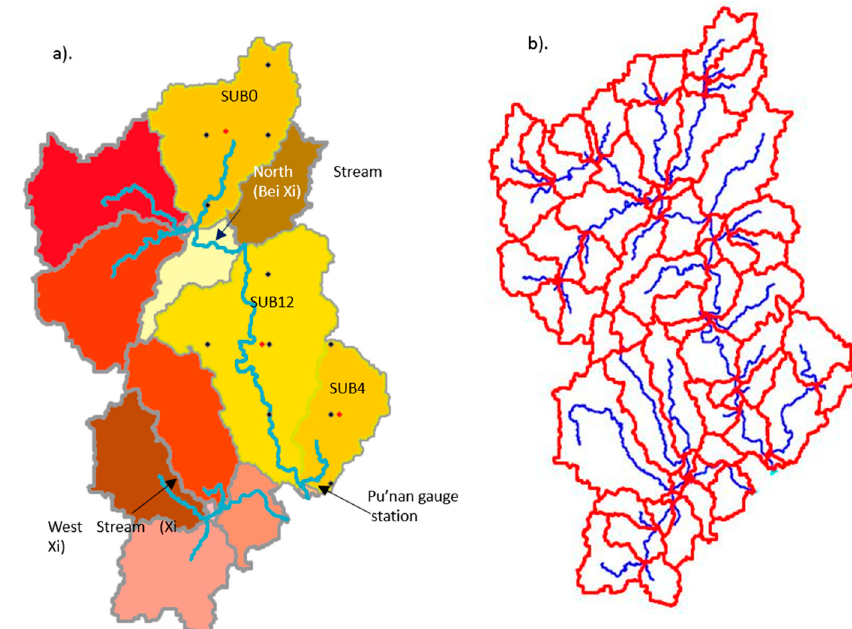
Figure 3. Two versions of watershed delineation. ( a ) Coarser delineation for data interpolation; ( b ) finer delineation for Hydrological Simulation Program-Fortran (HSPF) modeling. The three yellow subcatchments (SUB0, SUB12, and SUB4) contain the locations that are identified as crucial for runoff generation, and the WRF model output at these points (little black dots) within these sub-basins was subsequently interpolated utilizing the Thiessen Polygon method onto the centroids (red dots) of these sub-basins as HSPF input. See Section 2.4.2 “Preparing HSPF Input” for